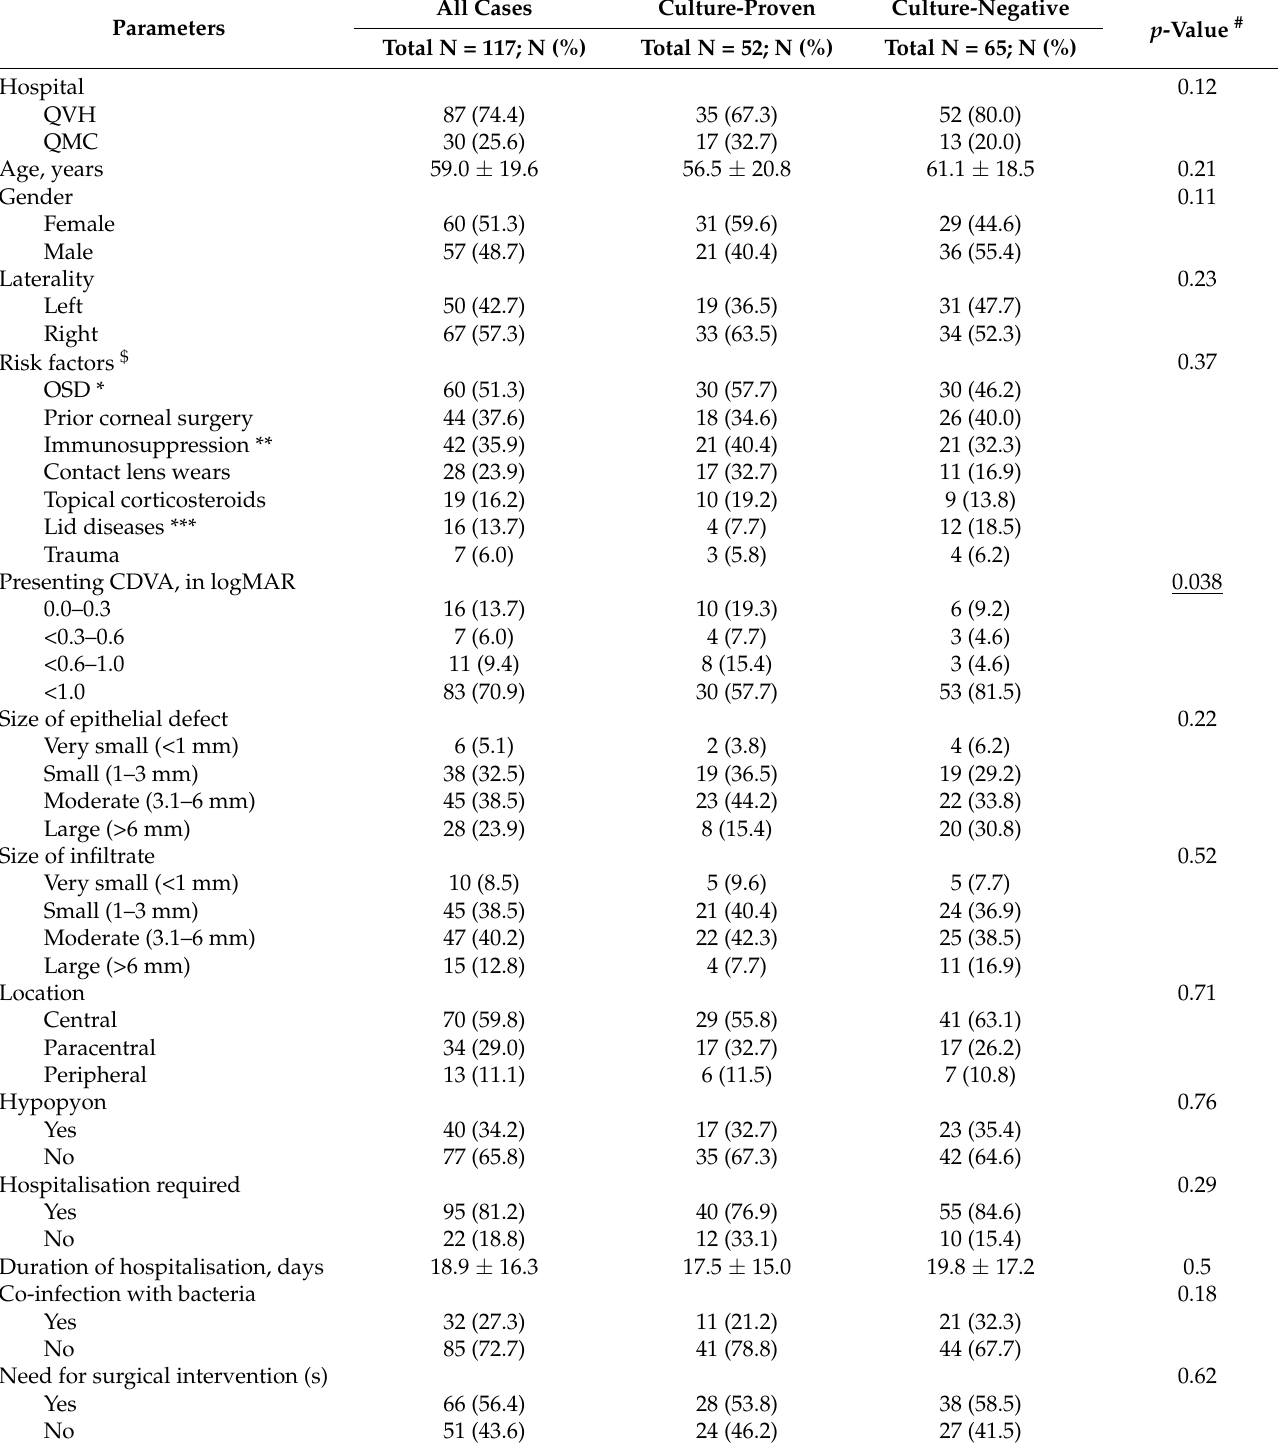
Table 1. Summary of the demographic factors, risk factors and baseline clinical characteristics of fungal keratitis presented to Queen’s Medical Centre (QMC), Nottingham, UK and Queen Victoria Hospital QVH), East Grinstead,